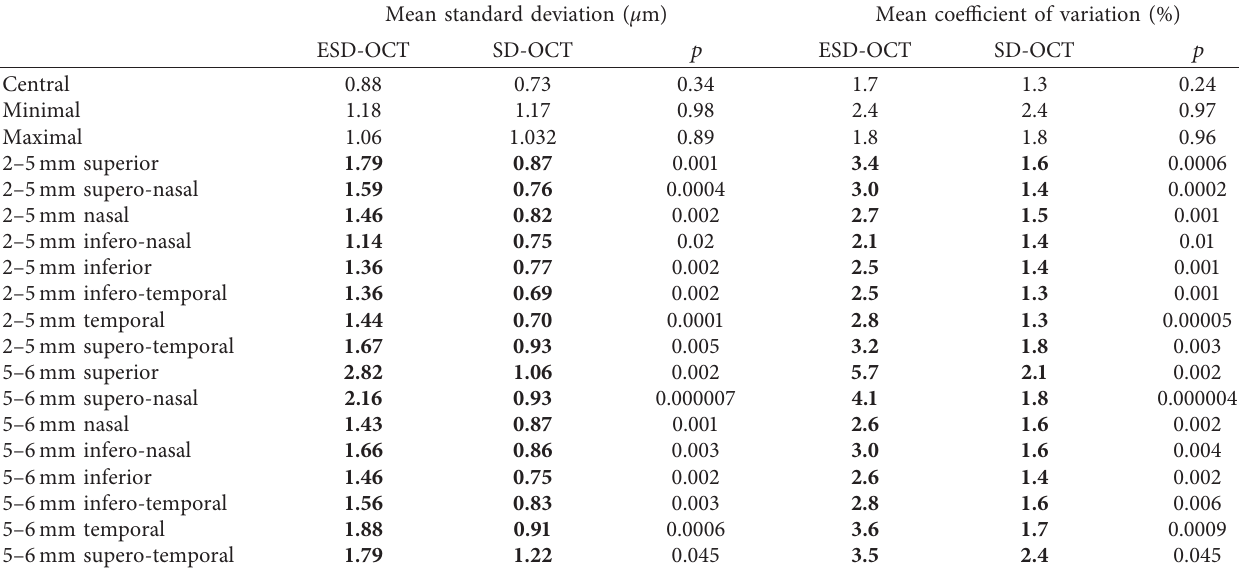
Table 1: Interobserver reproducibility of corneal epithelial thickness assessment with Enhanced Spectral-Domain and Spectral-Domain- Optical Coherence Tomography in normal eyes.